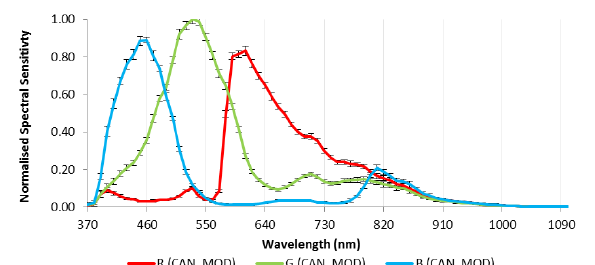
Figure 5: Spectral response for the modified to full spectrum Canon camera normalised to the peak of the green channel With a 585 nm long pass filter attached to the FS Canon camera (Figure 6A), the NIR peak in the blue channel could potentially be exploited as the blue channel is now the only channel that is predominately sensitive to NIR wavelengths and is beyond the red edge feature of 700~720 nm (Hunt et al ., 2010).